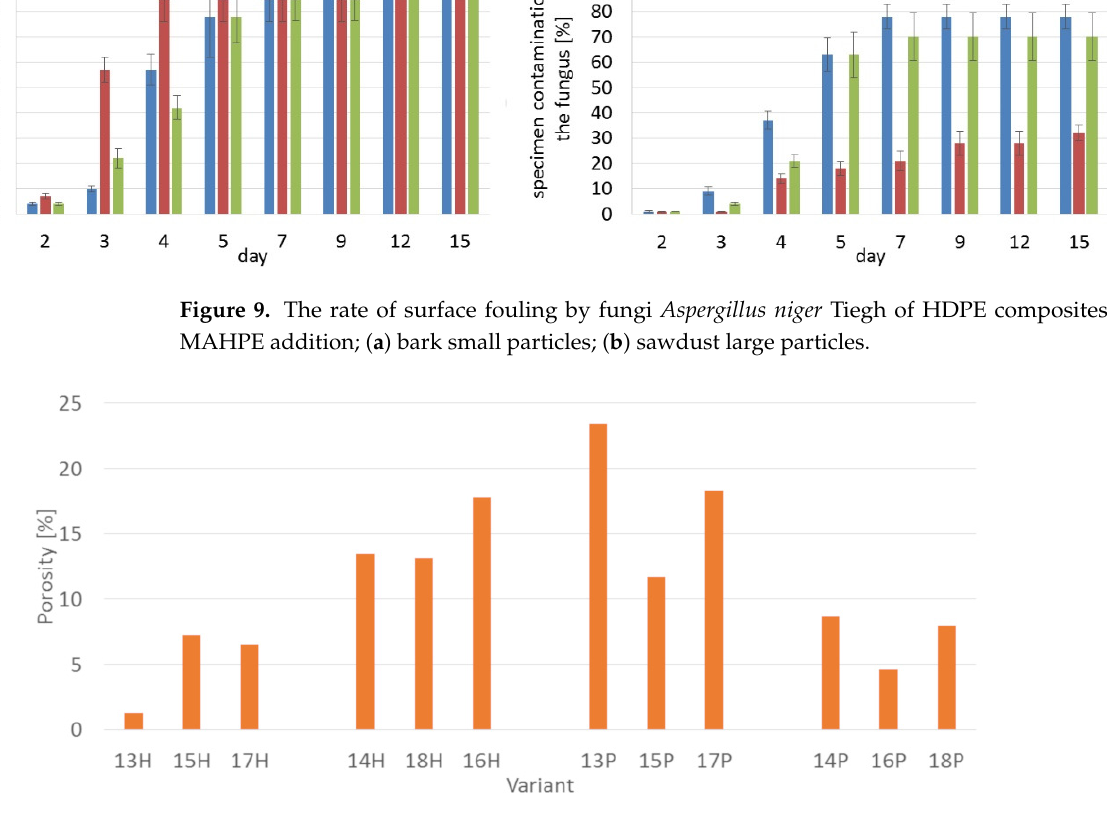
Figure 10. The porosity of the tested PLA and HDPE composites containing additives.